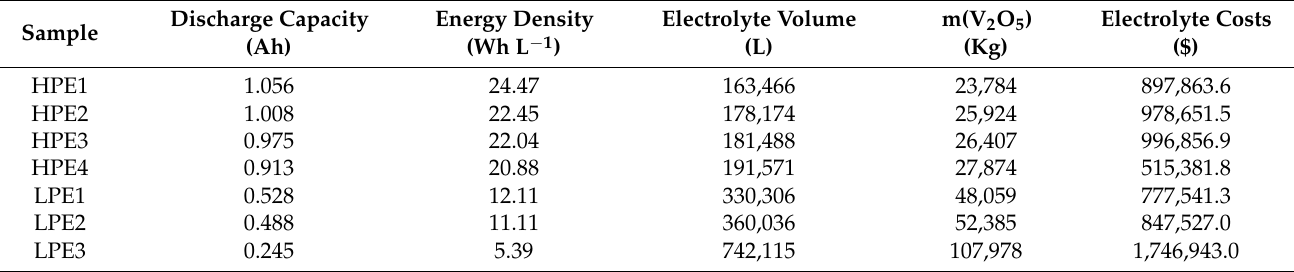
Table 4. The costs of electrolytes prepared with different grades of V 2 O 5 raw materials for a 1 MW/4 MWh VRFB system. Sample